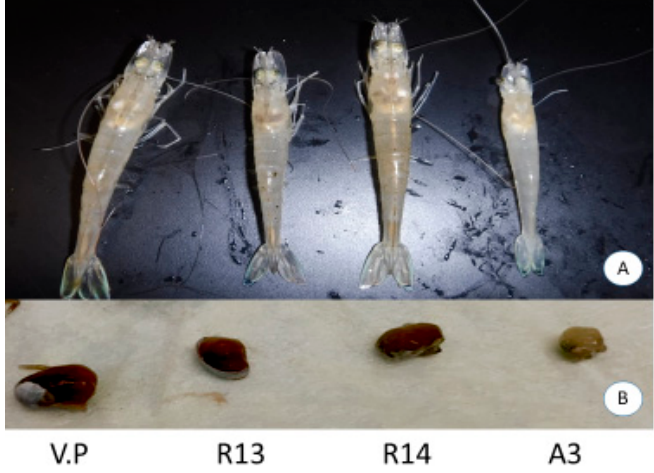
Figure 3. Clinical signs of shrimp, Penaeus vannamei, experimentally infected with four di ff erent isolates of Vibrio parahaemolyticus — V. parahaemolyticus ATCC strain (V.P), R13, R14 and A3 (AHPND reference strain). Panel ( A ): Shrimp on the left shows a normal color in the hepatopancreas and the shrimp on the right shows a pale discoloration on the hepatopancreas and an empty stomach—typical signs of AHPND-infected shrimp. The control shrimp (unchallenged) and the shrimp challenged with R13 and R14 all showed a normal color (dark brown) of hepatopancreas while all the shrimp challenged with the reference strain A3 showed a pale discoloration of the hepatopancreas. Panel ( B ) shows a sample of a typical hepatopancreas dissected from shrimp exposed to R13, R14 and A3. The shrimp infected with the A3 strain shows an atrophied and pale